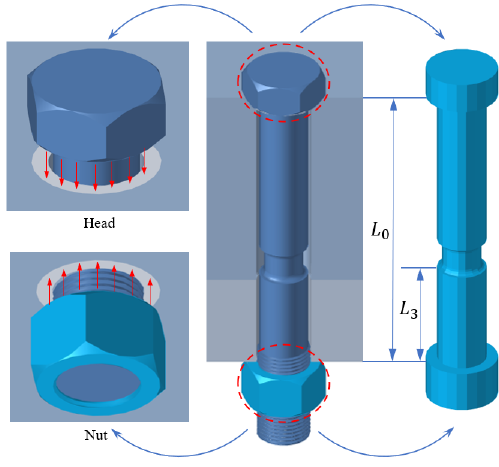
Figure 9. Simplified model of the bolted connection combination.